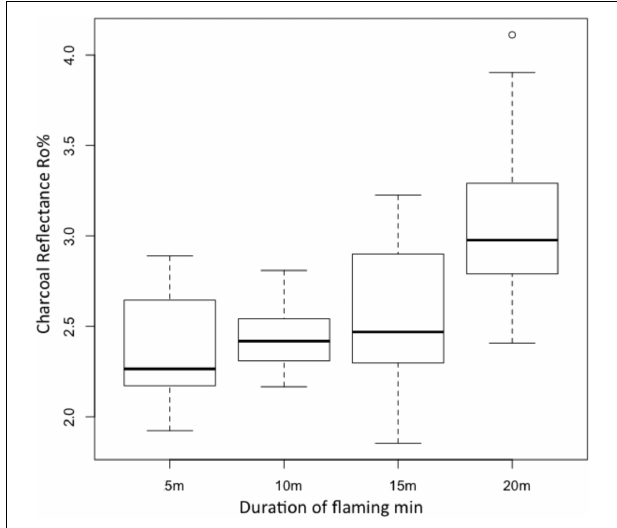
FIGURE 3 | Box plot of the range of measured charcoal reflectance values from WRC subject to 5, 10, 15, and 20 min flaming combustion where n = 90 for each box.